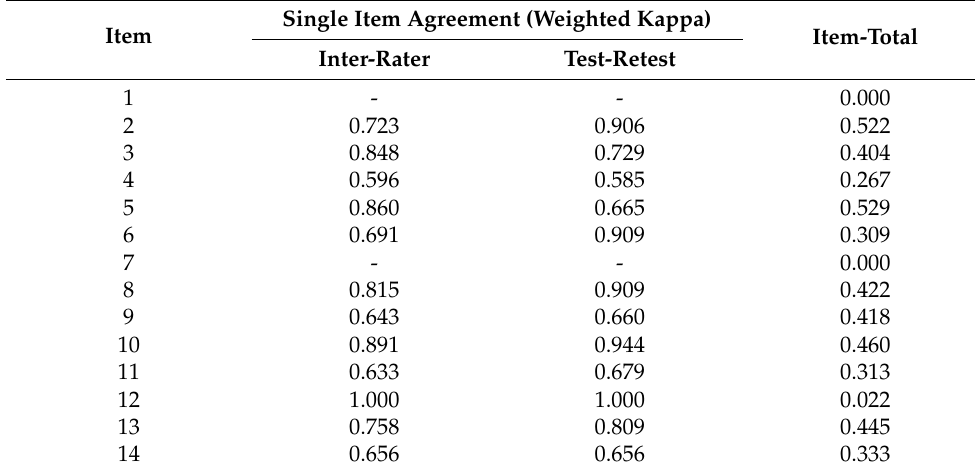
Table 2. Inter- and intra-rater agreement for a single item of the Mini-Balance Evaluation Systems Test (Mini-BESTest) and item-total correlation from n = 44.